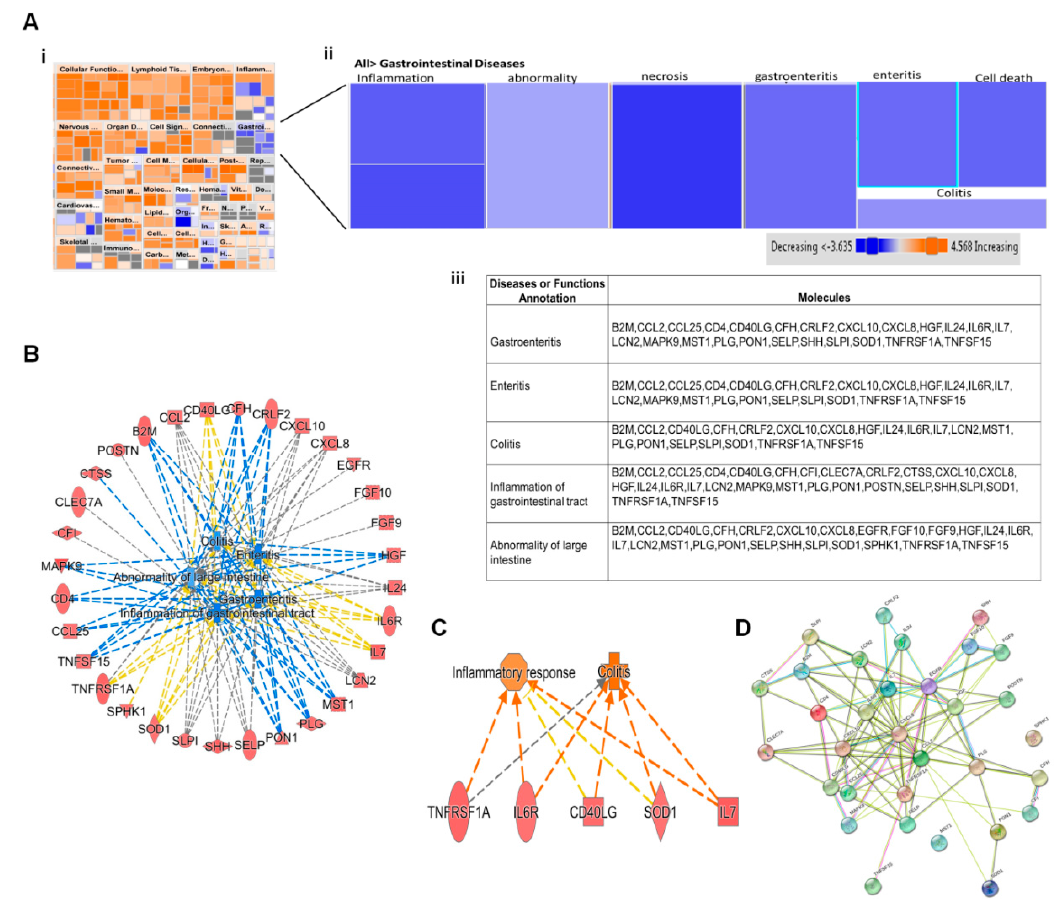
Figure 3. Proteomic prediction by IPA of Disease and function affected by ZIKV infection. ( A ) ( i ) and ( ii ) Heatmaps of various diseases and functions after 12 h of ZIKV infection. Among various disease and function predicted are various forms of gastrointestinal diseases. Predictions of activation of various disease and function were based on Z scores. Orange color represents activation; blue indicates inhibition. ( iii ) Tabulation of the various dysregulated host processes which are linked to various gastrointestinal diseases. ( B ) Protein-protein interaction among proteins in Figure 3iii generated by String software. ( C ) Networks of dysregulated host proteins linked to the various gastrointestinal diseases predicted by IPA. ( D ) Network of predicted e ff ect of increased expression of downstream molecules involved in